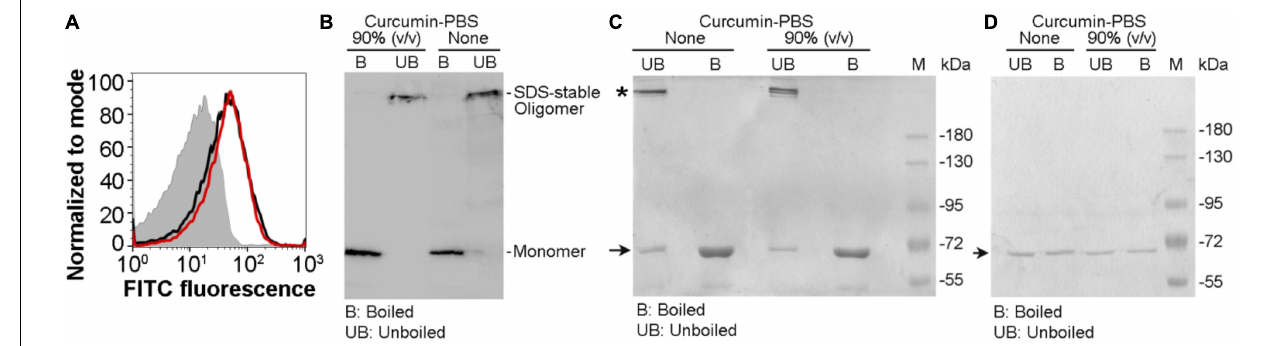
FIGURE 4 | Vibrio cholerae cytolysin retains its ability to bind to the target membranes and forms SDS-stable oligomeric assembly in the presence of the soluble aqueous extract of curcumin. (A) Flow cytometry-based assay showing binding of VCC with human erythrocytes in the presence of the soluble aqueous extract of curcumin in PBS [curcumin-PBS; 80% (v/v)] (red curve). The binding of VCC to the cells in the absence of curcumin extract is shown in black curve. The filled gray curve represents the control cells stained with primary and secondary antibodies, without the VCC treatment. The data shown here is representative of at least three independent experiments. (B) VCC retains its ability to form SDS-stable oligomers in the human erythrocytes membrane ghost in the presence of curcumin-PBS [90% (v/v)]. VCC was incubated with human erythrocytes membrane ghost in the presence or absence of curcumin-PBS, and the membrane-bound VCC was probed by pull down-based assay, followed by SDS-PAGE and immunoblotting. Sample treated with SDS-PAGE sample buffer without boiling allowed detection of the SDS-stable oligomers formed by VCC. The data shown here is representative of three independent experiments. (C) The ability of VCC to associate and form SDS-stable oligomers in the membrane lipid bilayer of Asolectin-cholesterol liposomes was probed by the pull down-based assay. Liposomes were treated with VCC in the absence or presence of curcumin-PBS [90% (v/v)], and liposome-bound pellet fractions were analyzed by SDS-PAGE and Coomassie staining, with or without